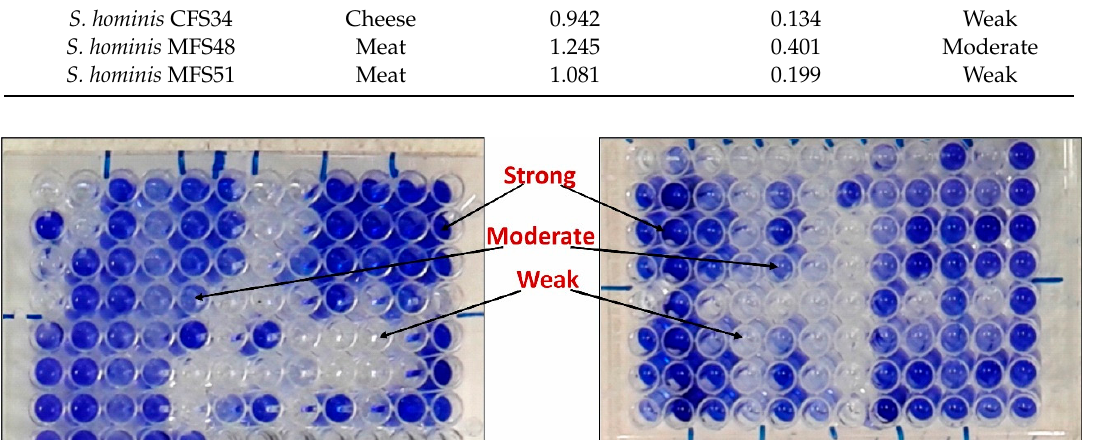
Figure 1. Microtiter ELISA plate shows the patterns of biofilm formation by MDR-CoNS strains .